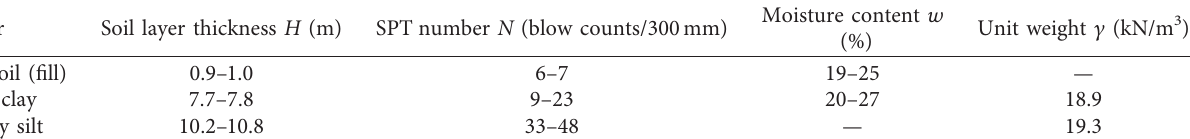
Table 1: Test site soil